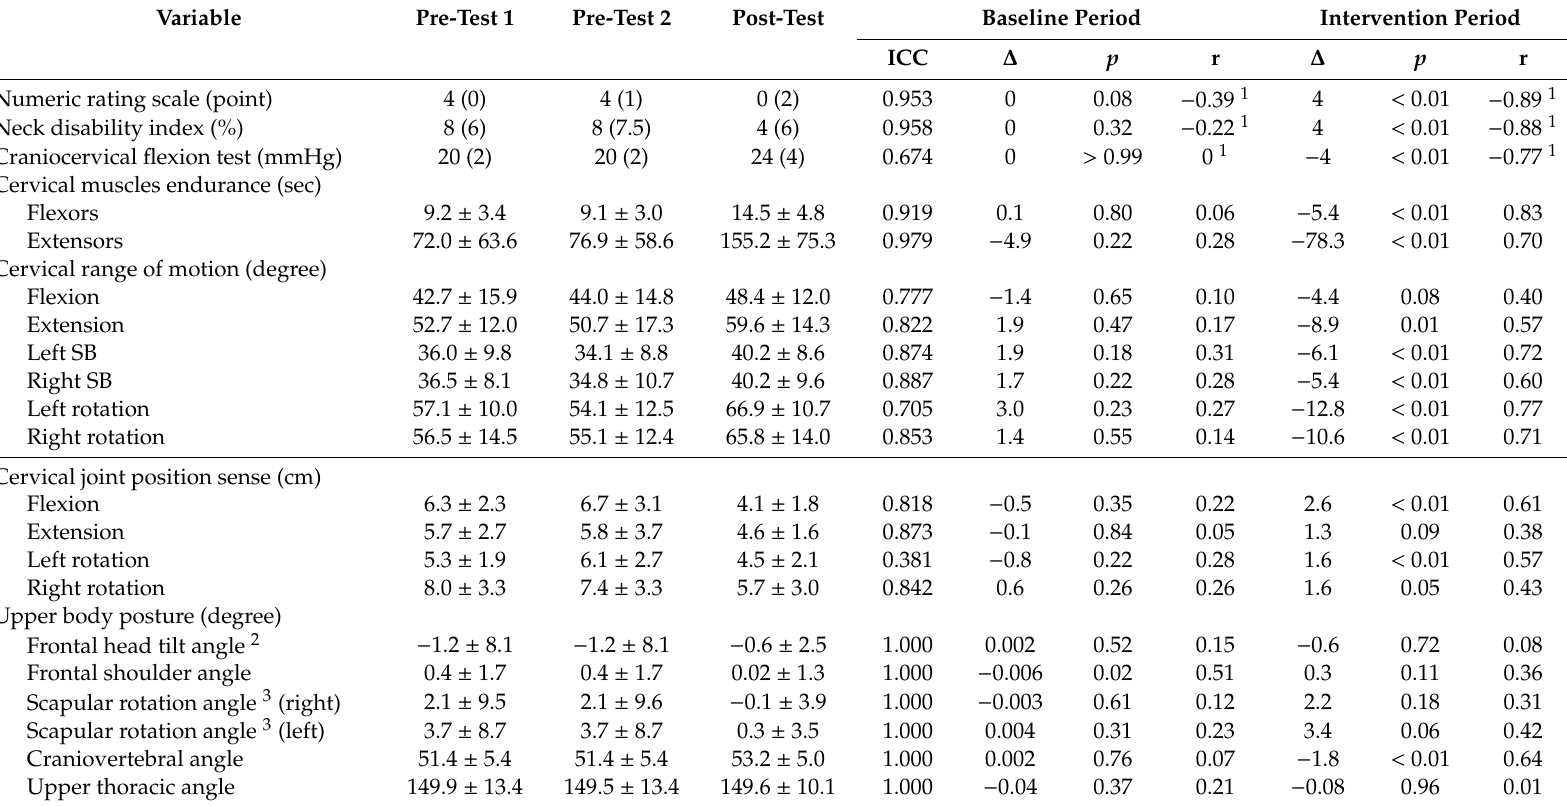
Table 1. Descriptive and inferential statistics of outcome measures (N =